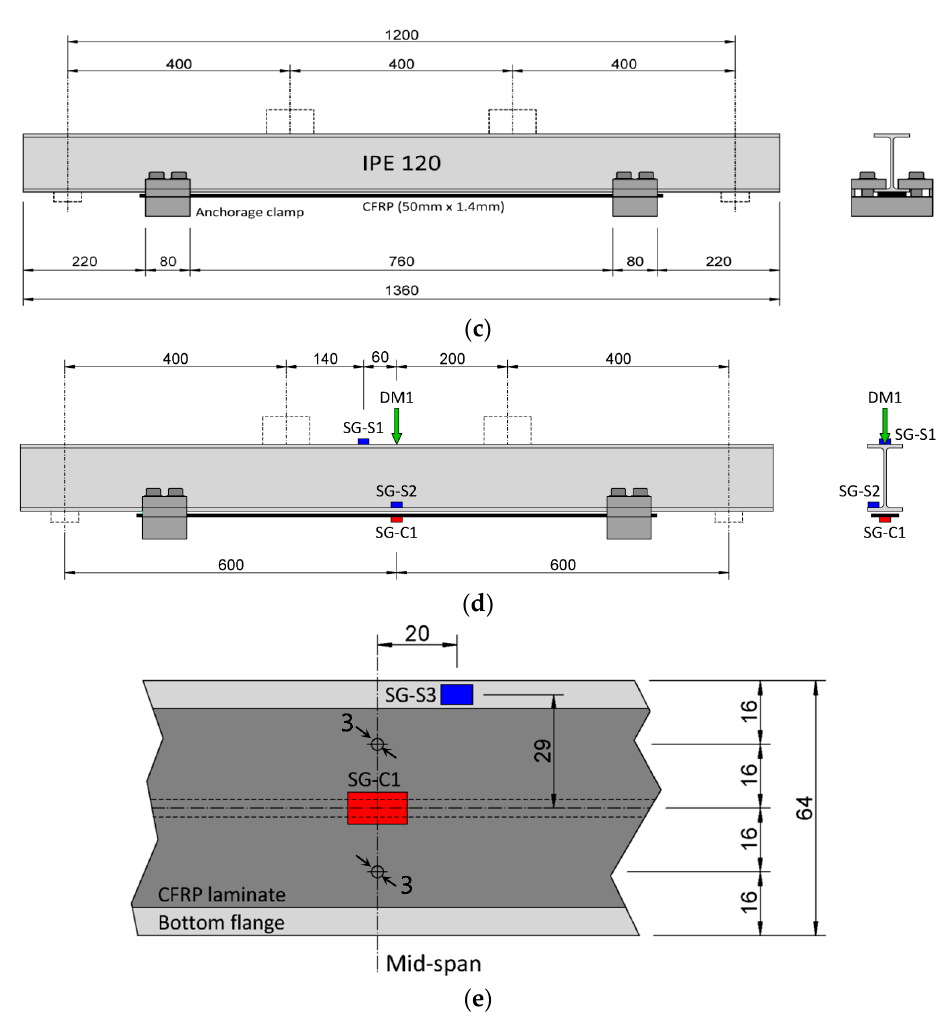
Figure 8. ( a ) Specimens strengthened with the BR system; ( b ) Measurement layout for the BR system; ( c ) specimens strengthened with the UR system; ( d ) measurement layout for the UR system [27]; ( e ) details of the two drilled holes in the bottom flange of the fatigue specimens, the CFRP laminate and strain gauges (dimensions in mm).